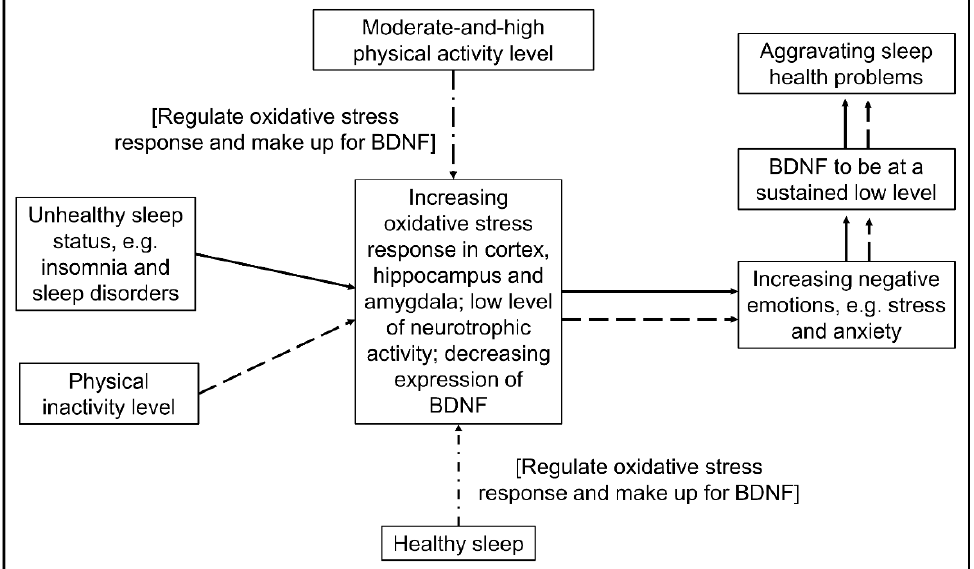
Figure 3. Possible schematic diagram of interactive compensation and regulation effects of physical activity and sleep on mental health referring to previous studies [43 – 45]. Note: BDNF, brain-derived neurotrophic factor. The solid line shows the influence path of sleep on mental health while the dashed line shows the influence path of physical activity on mental health. Furthermore, the dot-dash line represents the interactive regulation and compensation path.